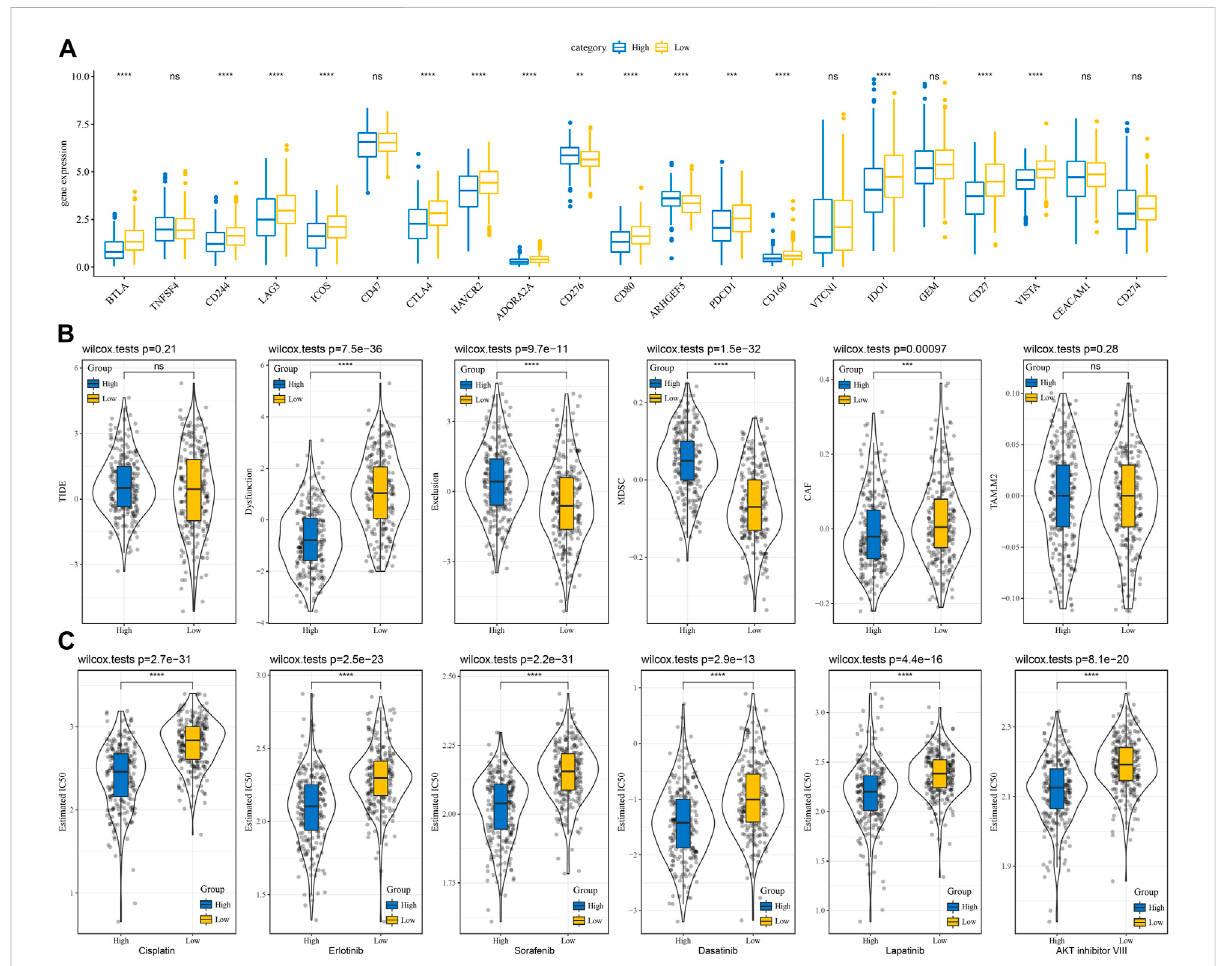
FIGURE 7 DifferencesinimmunotherapyandchemotherapyscoresbetweenRiskScoregroups. (A) Immunecheckpointsdifferentiallyexpressedbetween two risk groups in the TCGA cohort; (B) Differences in TIDE analysis results between two risk groups in the TCGA cohort; (C) The box plots of the estimated IC50 for cisplatin, Erlotinib, Sunitinib, Paclitaxel, Sorafenib, Crizotinib in TCGA cohort. ns, not signi fi cant. ** p < 0.01, *** p < 0.001, **** p <